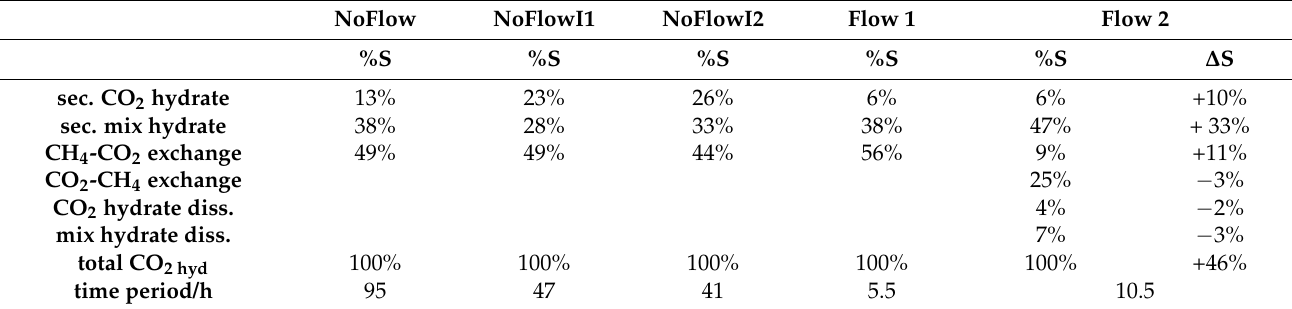
Table 2. The percentage of the CO 2 hydrate signal (%S) that was attributed to the respective individual processes and the contribution of these processes to the change of the total CO 2 hydrate signal ( ∆ S). Flow 1 is the flow period of experiment Flow and Flow 2 is the no-flow period of experiment Flow . For both flow periods, 100% depicts the CO 2 signal at the end of the Flow 1 period: In the first case, it is the final signal, and in the second case, it is the initial signal. Hence, %S and ∆ S for the Flow 2 period refers to the initial signal and not to the final signal. The duration of the experimental period is given in the last